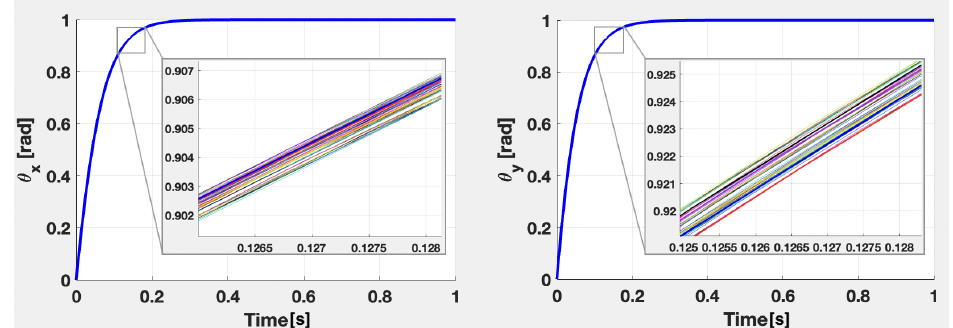
Figure 4. The step responses of the nominal closed-loop system, along with 50 Monte Carlo simula- tions for X axis ( left ) and Y axis ( right ), obtained by adding the feedforward component.